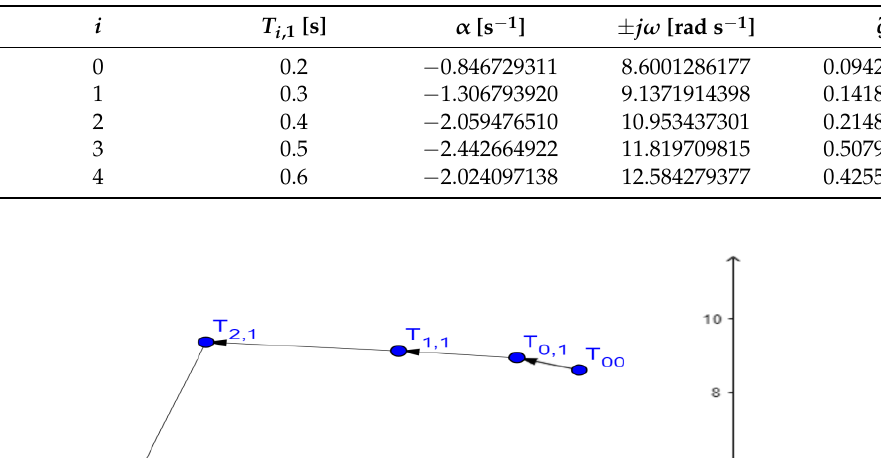
Table 3. Dominant oscillatory pole for PSS parameters K = 10, T = T i,1 = 0.2 s – 0.6 s ( cluster 1 ).